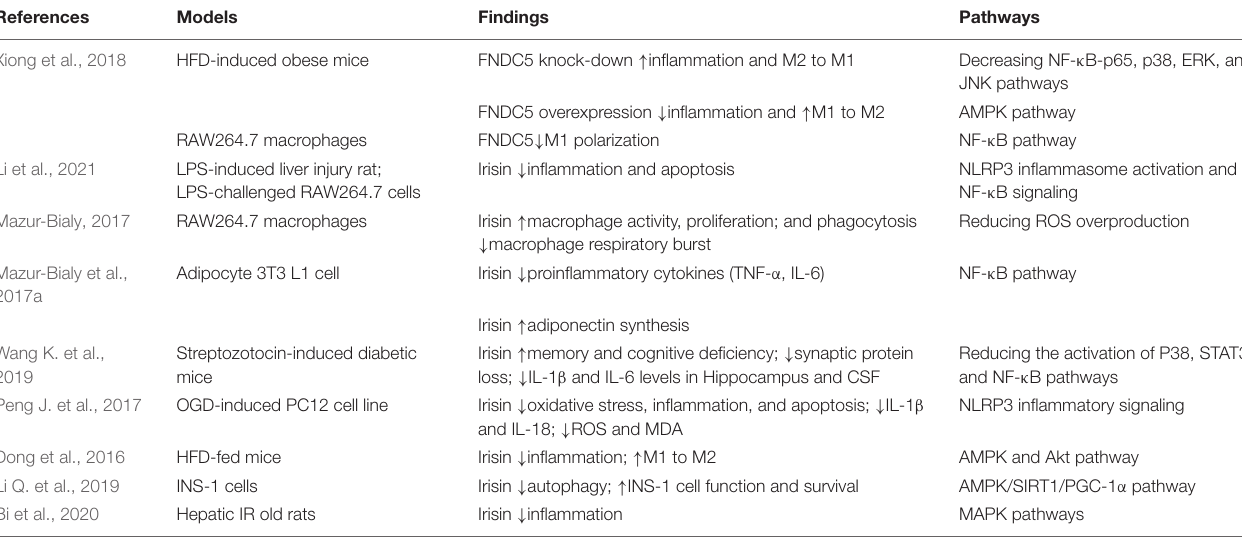
TABLE 1 | Experimental studies suggesting the roles of FNDC5/irisin in